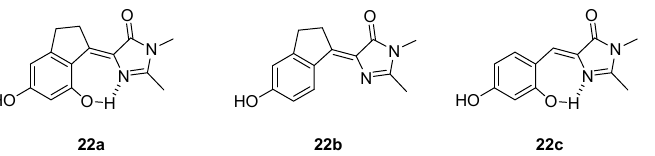
Figure 22. GFPc analogues presenting a hydrogen bond and/or a cyclic substituent [37].